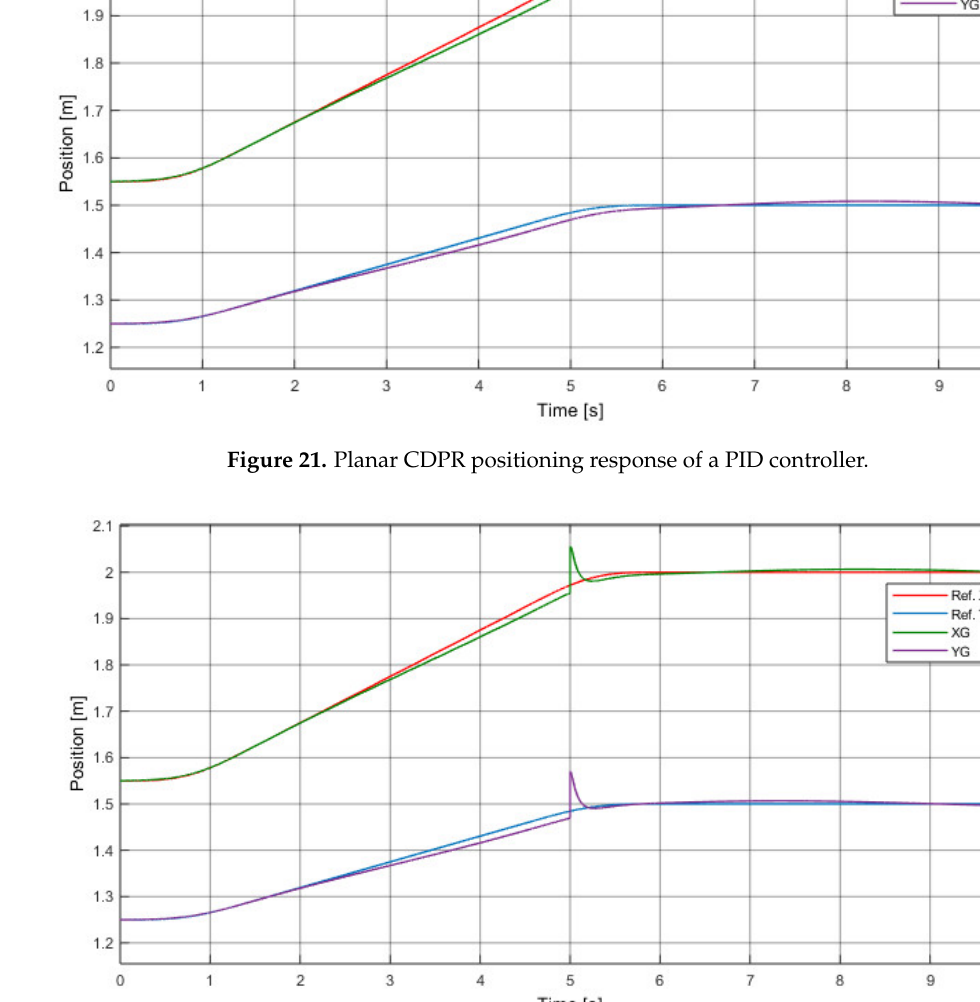
Figure 23. Planar CDPR positioning response of a fuzzy PID controller.